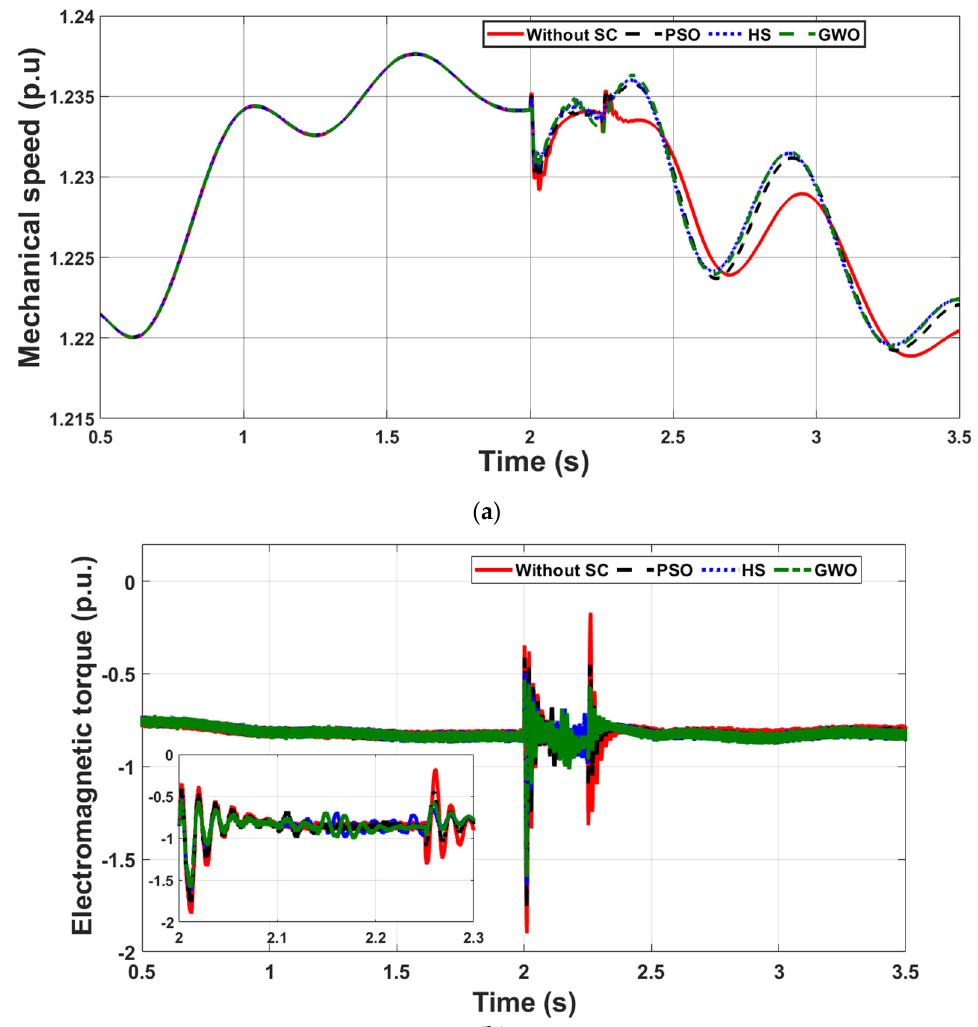
Energies 2021 , 14 , x FOR PEER REVIEW Figure 9. DFIG mechanical shaft behavior during the voltage swell case study: ( a ) shaft speed, ( b ) electromagnetic torque.